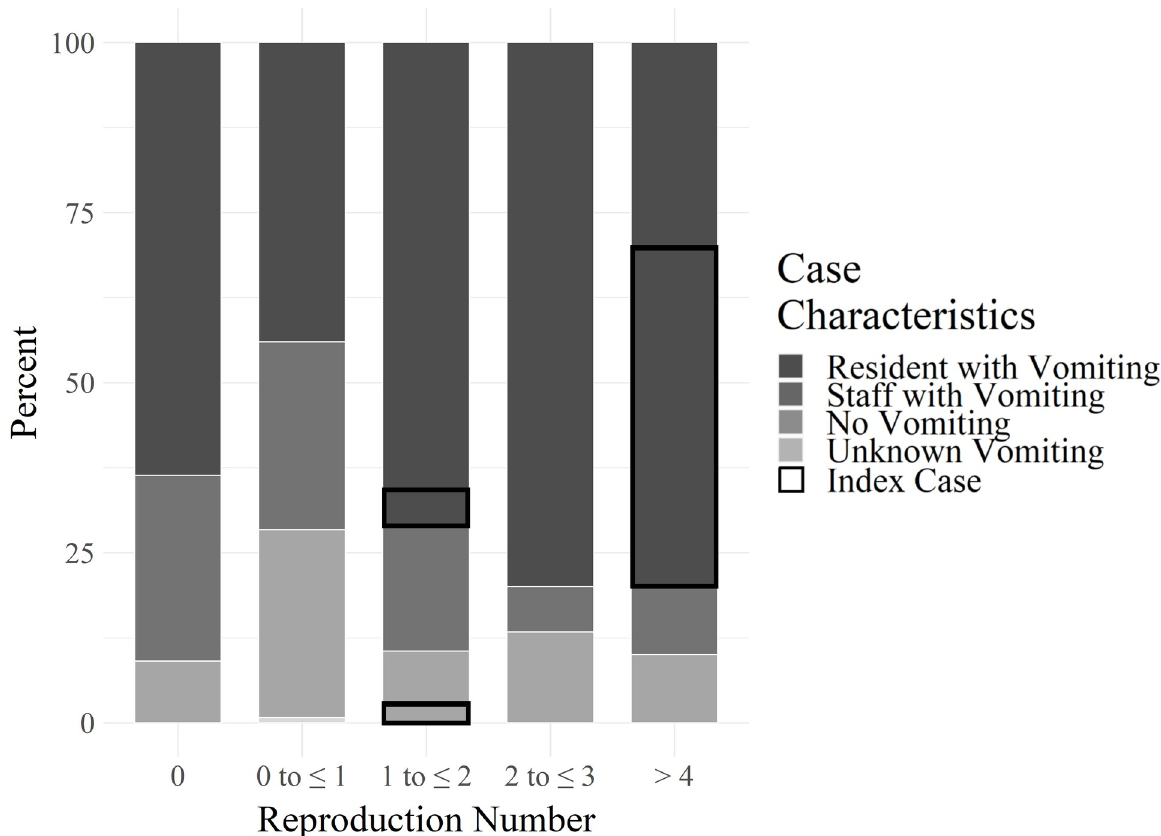
Fig 2. Percentage of cases by individual reproduction number a , R Ei , for the following categories: residents who vomited, staff who vomited, residents/staff who did not vomit, and residents/staff with unknown vomiting; index cases are outlined in black. a Individual reproduction number describes the number of secondary cases generated by an infectious